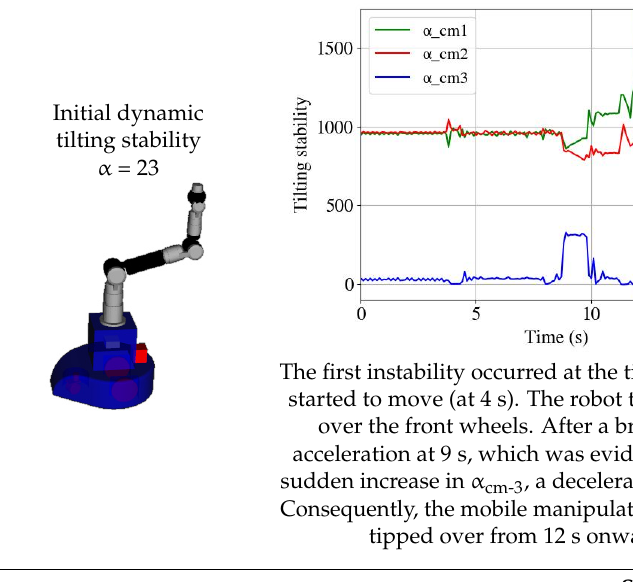
Table 3. Comparative scenarios in order to verify the effectiveness of the active stabilization by means of simulations.